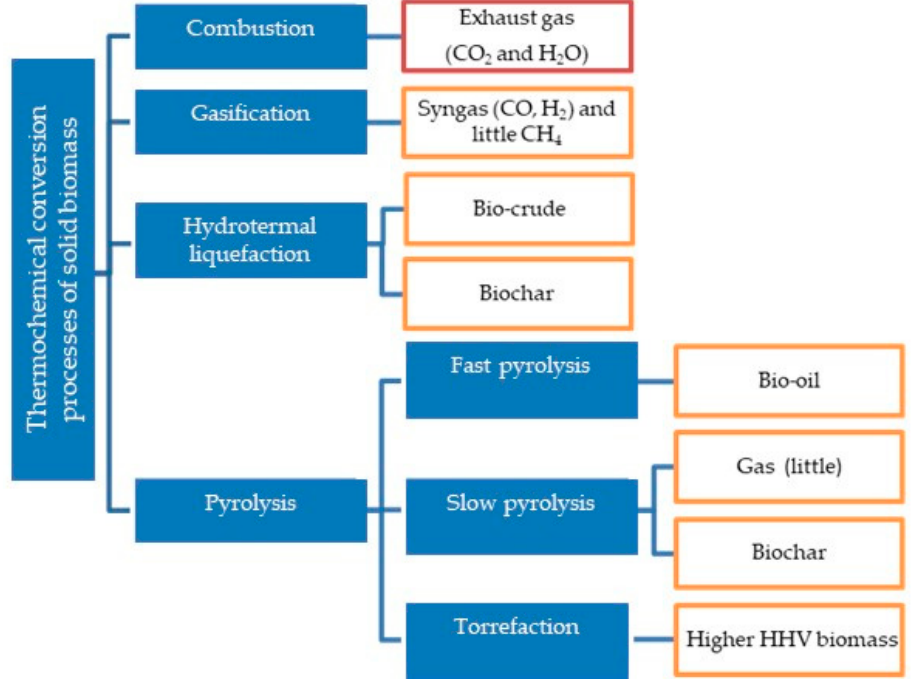
Figure 1. Thermochemical processes for production of fuels or chemical products (orange rectangles) and thermal energy (red rectangles) from solid biomass.